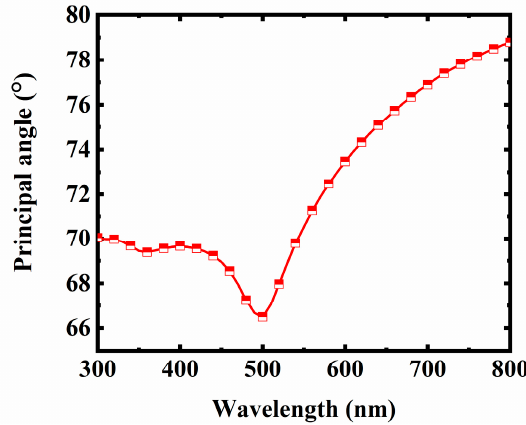
Figure 3. Spectrum of the principal angle for bulk Au.